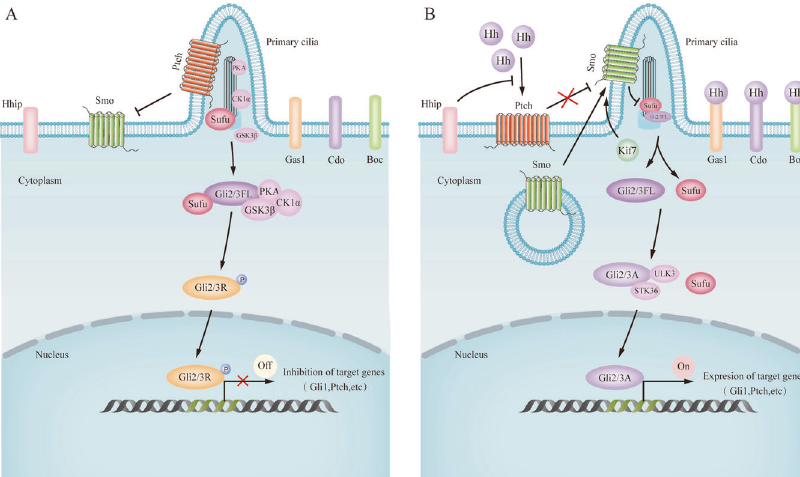
Fig. 1 Schematic diagram of paracrine Hh signalling in the mammalian intestine. Hh ligands are secreted by intestinal epithelial cells. The signals are received by various types of mesenchymal cells. In the absence of Hh ligands ( A ), the receptor Ptch localises in the primary cilium (PC) and inhibits Smo, a necessary receptor to deliver Hh signals, movement to the primary PC. Under such cases, Sufu restrains the full-length form of Glioma-associated oncogenes 2/3 (Gli2/3FL) in the cytosol, where they are partially phosphorylated and proteolyzed by a multiple protein kinase complex composed of PKA, GSK3 β , and CK1 α . This generates the repressor form, namely Gli2/3 repressor (Gli2/3 R), which translocates to the nucleus to bind to and inhibit the expression of Hh target genes. In the presence of Hh ligands ( B ), binding of Hh ligands to Ptch removes the inhibitory action of Ptch on Smo and drives the accumulation and activation of Smo in the PC, leading to subsequent inhibition of Sufu by Smo and the dissociation of Gli2/3FL. kinesin family member 7 (Kif7), a core regulator of mammalian Gli proteins, moves from the basal body to the tip of the PC in a Hh-dependent manner, assisting Smo accumulation in the PC. Gil2/3FL is then phosphorylated by serine/threonine protein kinases, including ULK3 and STK36, resulting in the formation of Gli2/3 activator (Gle2/3 A) and translocation into the nucleus. Once in the nucleus, Gli2/3 A upregulates the transcriptional targets of Hh signalling, including Ptch and another Hh-binding protein, Hhip. Gas1, Cdo, and Boc are co-receptors that promote Hh-Ptch binding. Arrows and blunt ends lines indicate activation and inhibition, respectively. Ptch Patched, Smo Smoothened, Hhip Hedgehog interacting protein, Gas1 Growth arrest-speci fi c gene 1, Cdo Cell adhesion molecule-related, downregulated by oncogenes; Boc, Brother of Cdo; Gli2/3FL, full-length form of Glioma-associated oncogenes 2/3, Gli2/3 A activator form of Glioma-associated oncogenes, Gli2/3 R repressor form of Glioma-associated oncogenes 2/3, Sufu Suppressor of Fused, Kif7 kinesin family member 7, PKA protein kinase A, GSK3 β glycogen synthase kinase 3 β , CK1 α casein kinase 1 α STK36 serine/threonine protein kinase 36, ULK3 UNC-51-like kinase